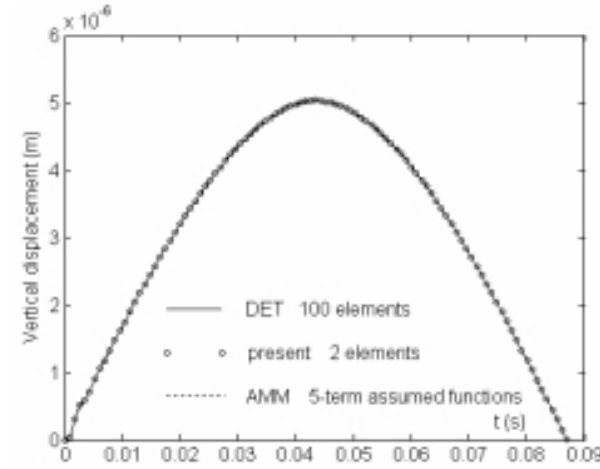
Fig. 5. Time history of dynamic vertical displacement of beam mid-point with three different